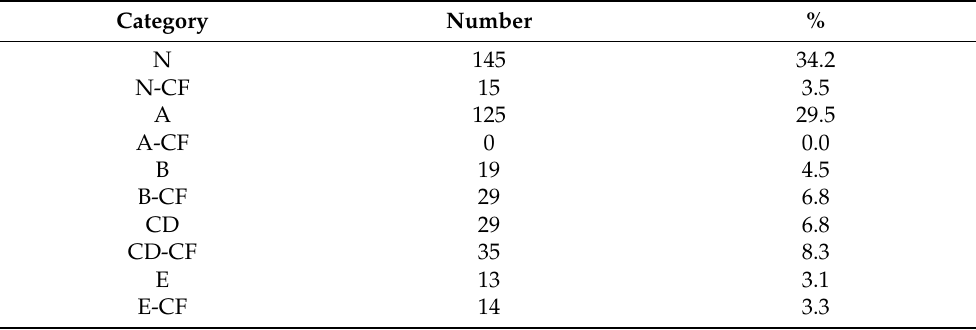
Table 1. Full dataset waveform distribution according the simplified Saint-Bonnet